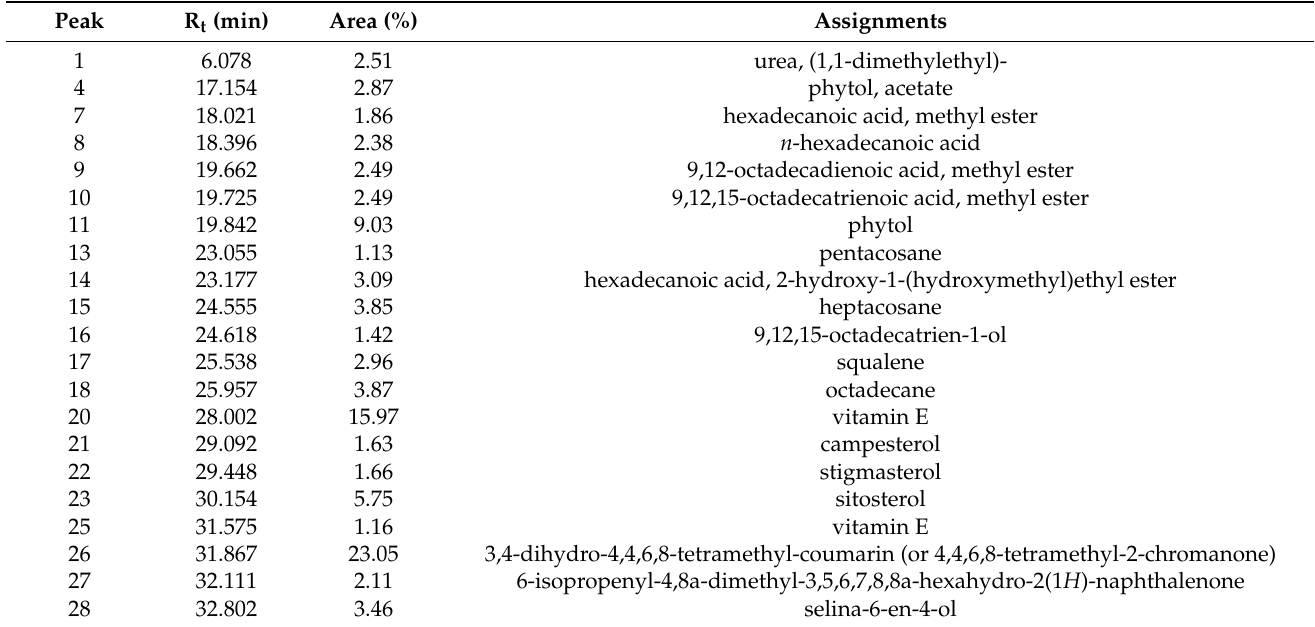
Table 4. Main compounds identified in Hibiscus syriacus leaf hydromethanolic extract by GC–MS.